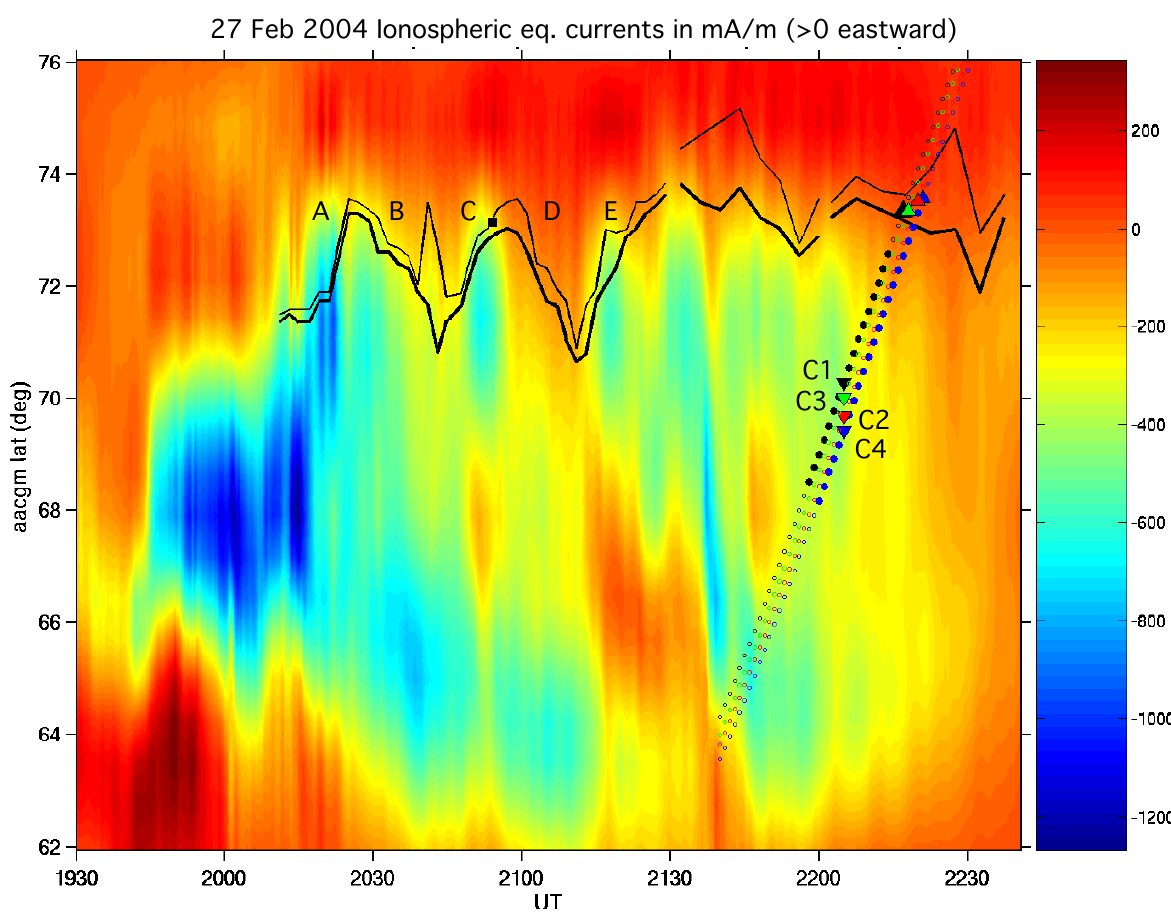
Fig. 5. Equivalent east-west current as deduced from the MIRACLE data. The thick (thin) black line indicates the polar cap boundary from the EISCAT VHF radar by using Method 1 (Method 2). The dotted lines are mapped Cluster s/c C1–C4 locations and the filled circles indicate positions where C1 and C4 observe ion outflow. The triangles with tip down are the locations of the s/c at 21:05UT. The orbits of the satellites in latitude and longitude are shown in Fig. 1. The triangles with tip up are the locations of the PCB by each s/c (see text). The black square shows the PCB location from FAST data. Letters from A to E are same time intervals as in Fig.